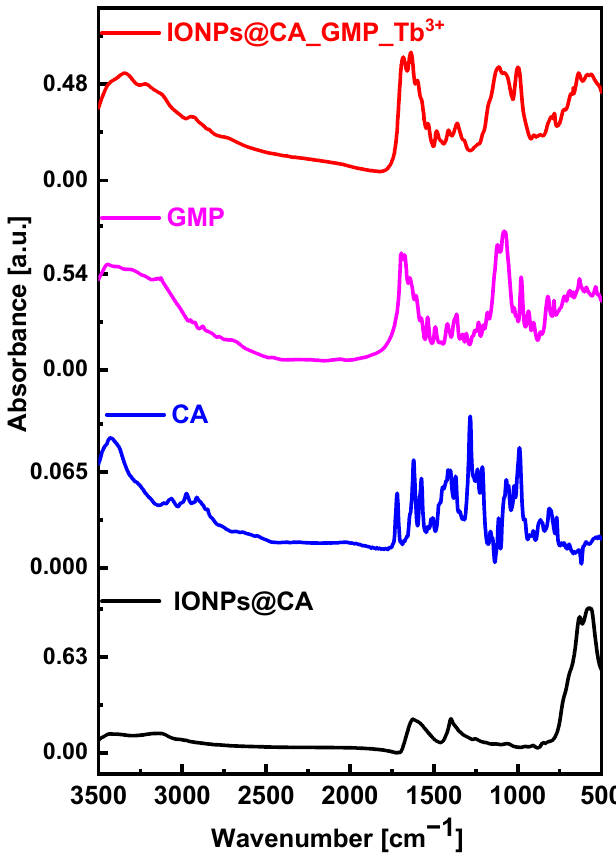
Figure 6. FTIR spectra of: IONPs@CA_GMP_Tb 3+ (red curve), GMP (magenta curve), CA (blue curve), IONPs@CA (black curve).